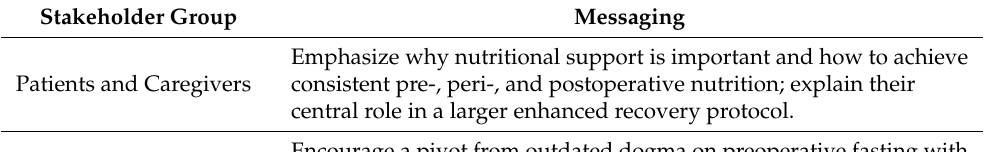
Table 4. Stakeholder Messaging for Improved Nutritional Assessment and Management in Pediatric